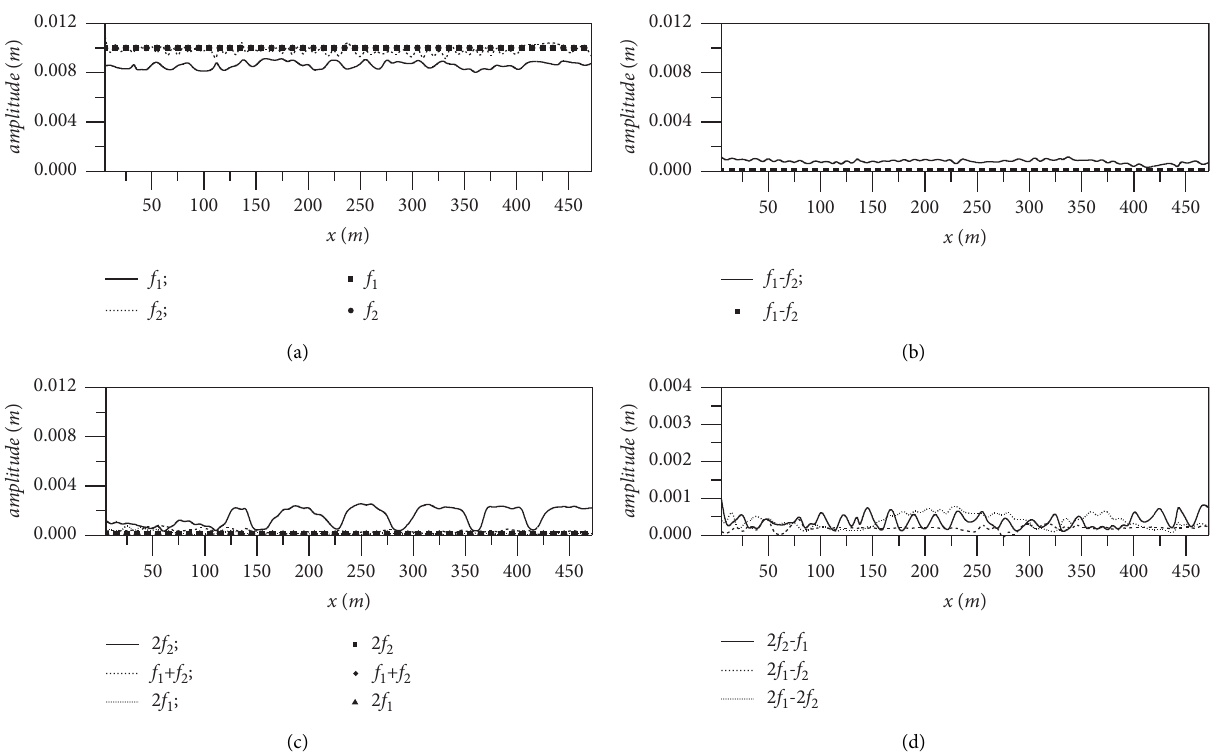
Figure 9: Comparisons of the spatial variation of amplitudes of each frequency component between calculation and theoretical results for case